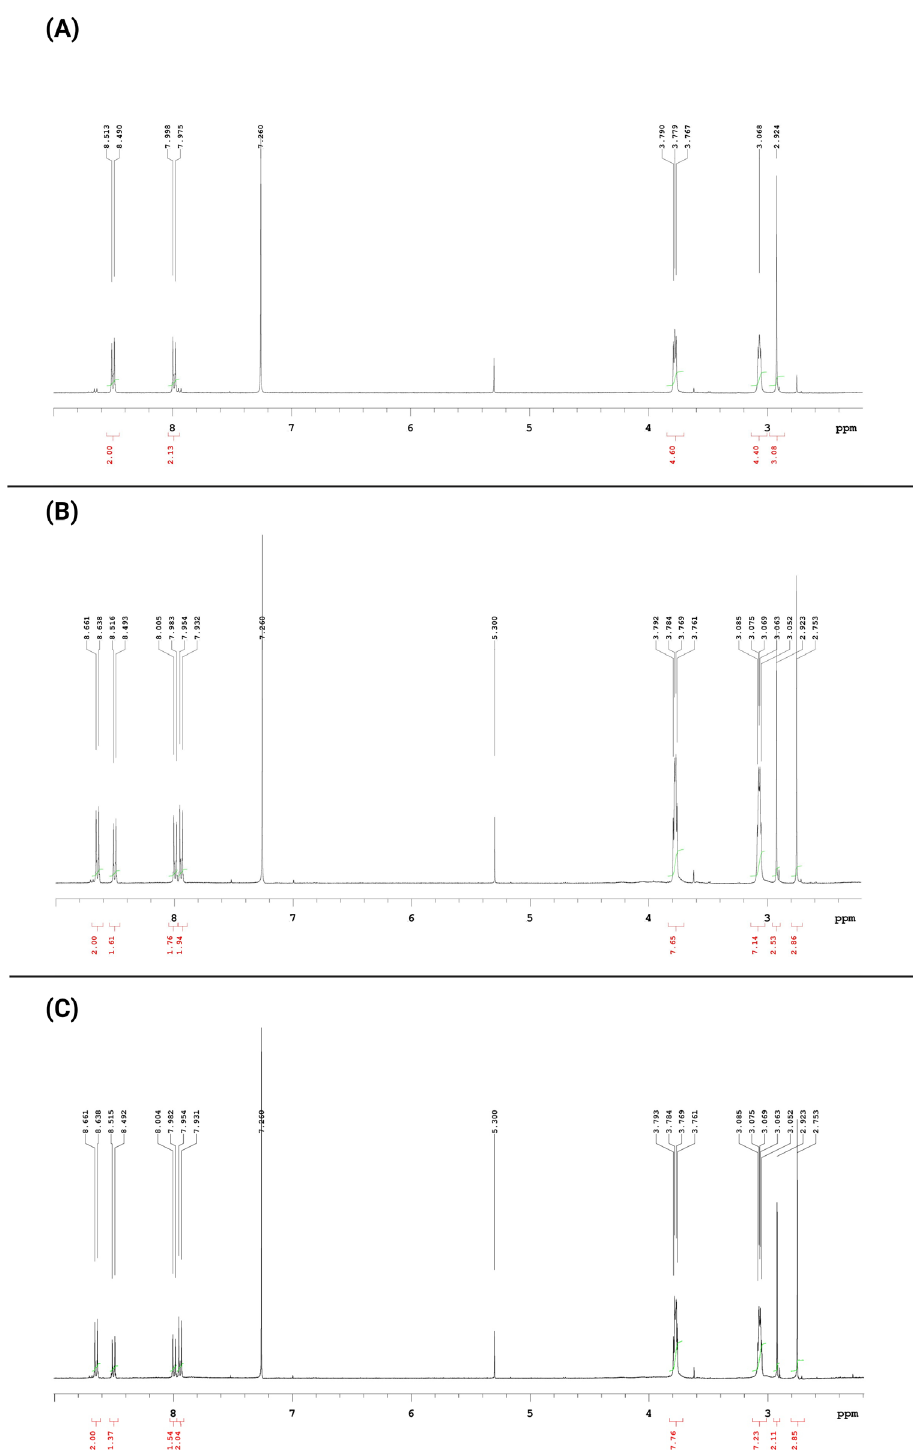
Figure 3. The 1 H NMR spectrum ( A ) recorded immediately after solution of the compound MM134 in deuterated chloroform and repeated ( B ) after 24 h and ( C ) after 48